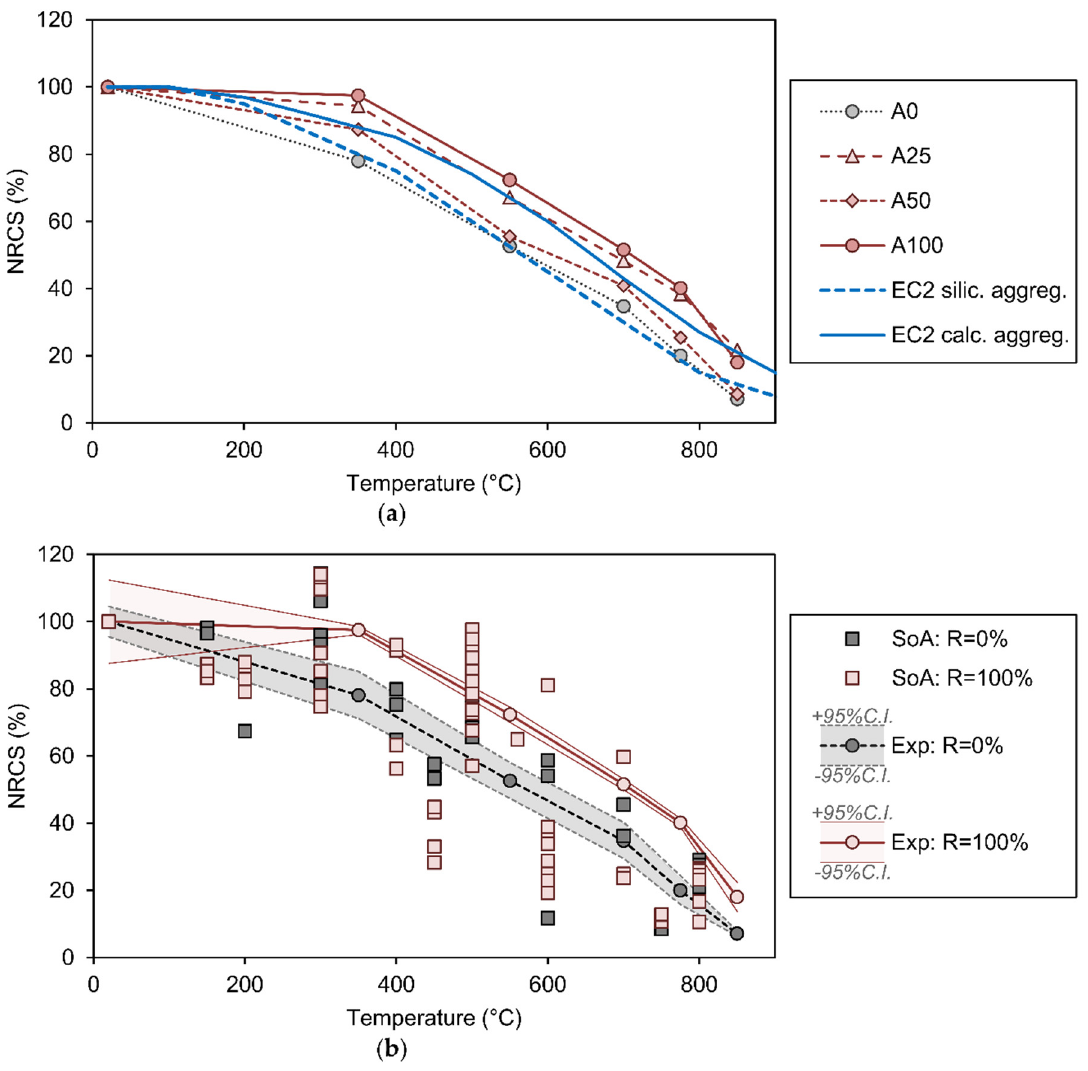
Figure 4. Evolution of normalised compressive strength (NRCS) with high temperatures: ( a ) experimental results for replacements of 0%, 25%, 50% and 100%, compared with NAC curves from Eurocode 2 [21]; ( b ) experimental results for replacements of 0% and 100%, compared with results from state-of-the-art (SoA).